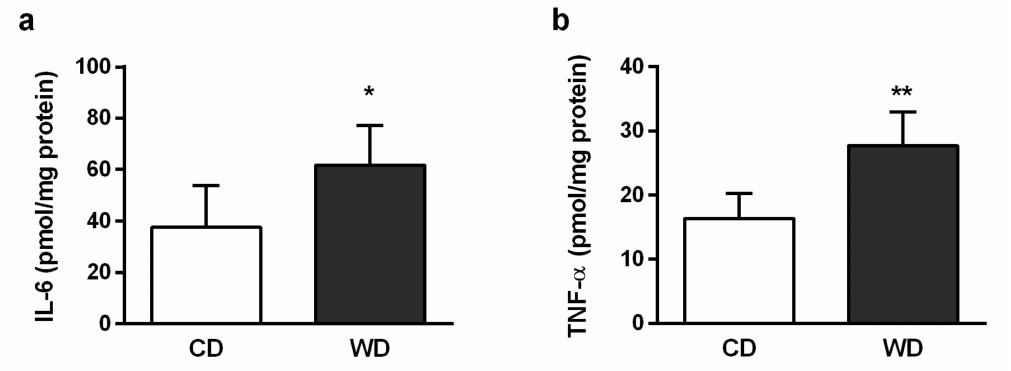
Figure 4. Hepatic inflammatory cytokines in mice fed a control diet (CD) and a Western-style diet (WD). ( a ) Levels of liver interleukin 6 (IL-6) and ( b ) tumor necrosis factor alpha (TNF- α ). The results are expressed as the means ± SD; * p < 0.05, ** p < 0.01 ( n = 6 each group).